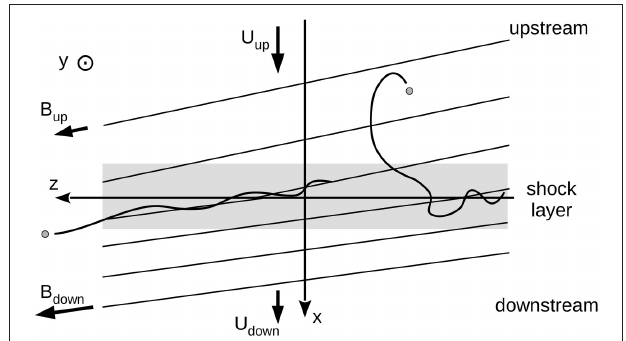
FIGURE 1 | Sketch on adiabatically parallel-accelerated electron (left) and non-adiabatically scattered electron back to the upstream region